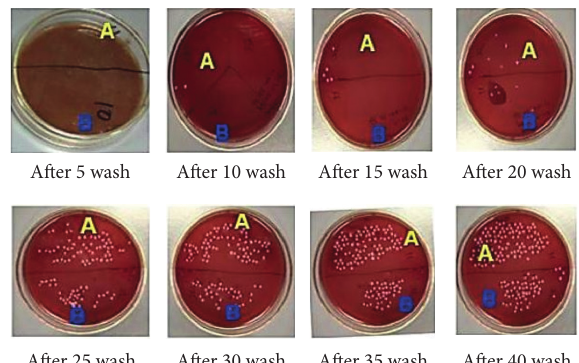
Figure 7: The test results of wash durability for the treated fabrics (note: A: Escherichia coli ; B: Staphylococcus aureus ).